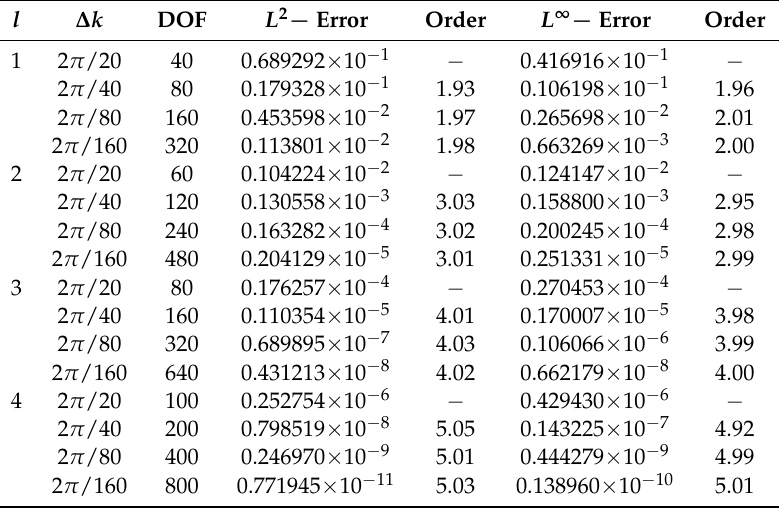
Table 1. Convergence study of the initial value